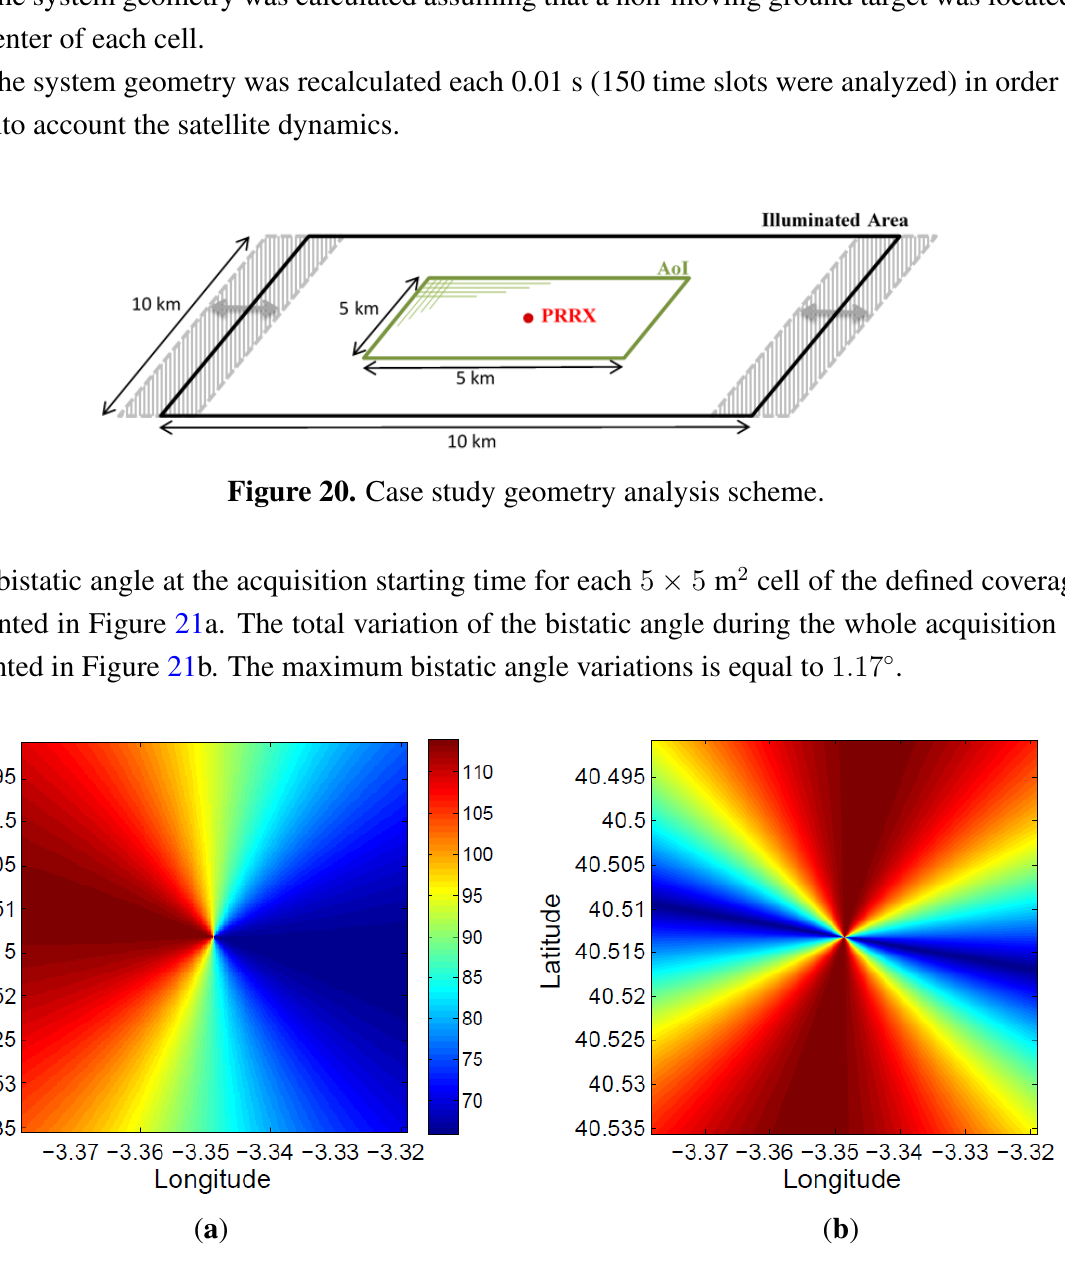
Figure 21. Study of the spatial and time variation of the bistatic angle: ( a ) initial value at each 5 × 5 m 2 cell of the coverage area; ( b ) total variation during the acquisition